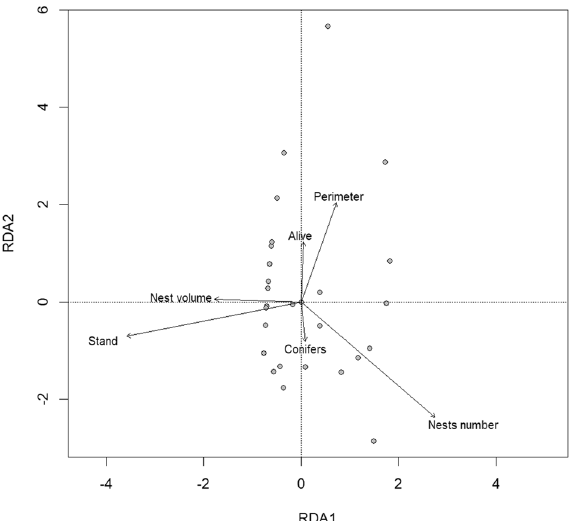
Figure 1. Graphical representation of the RDAs (redundance analyses) on the biotic an abiotic variables.